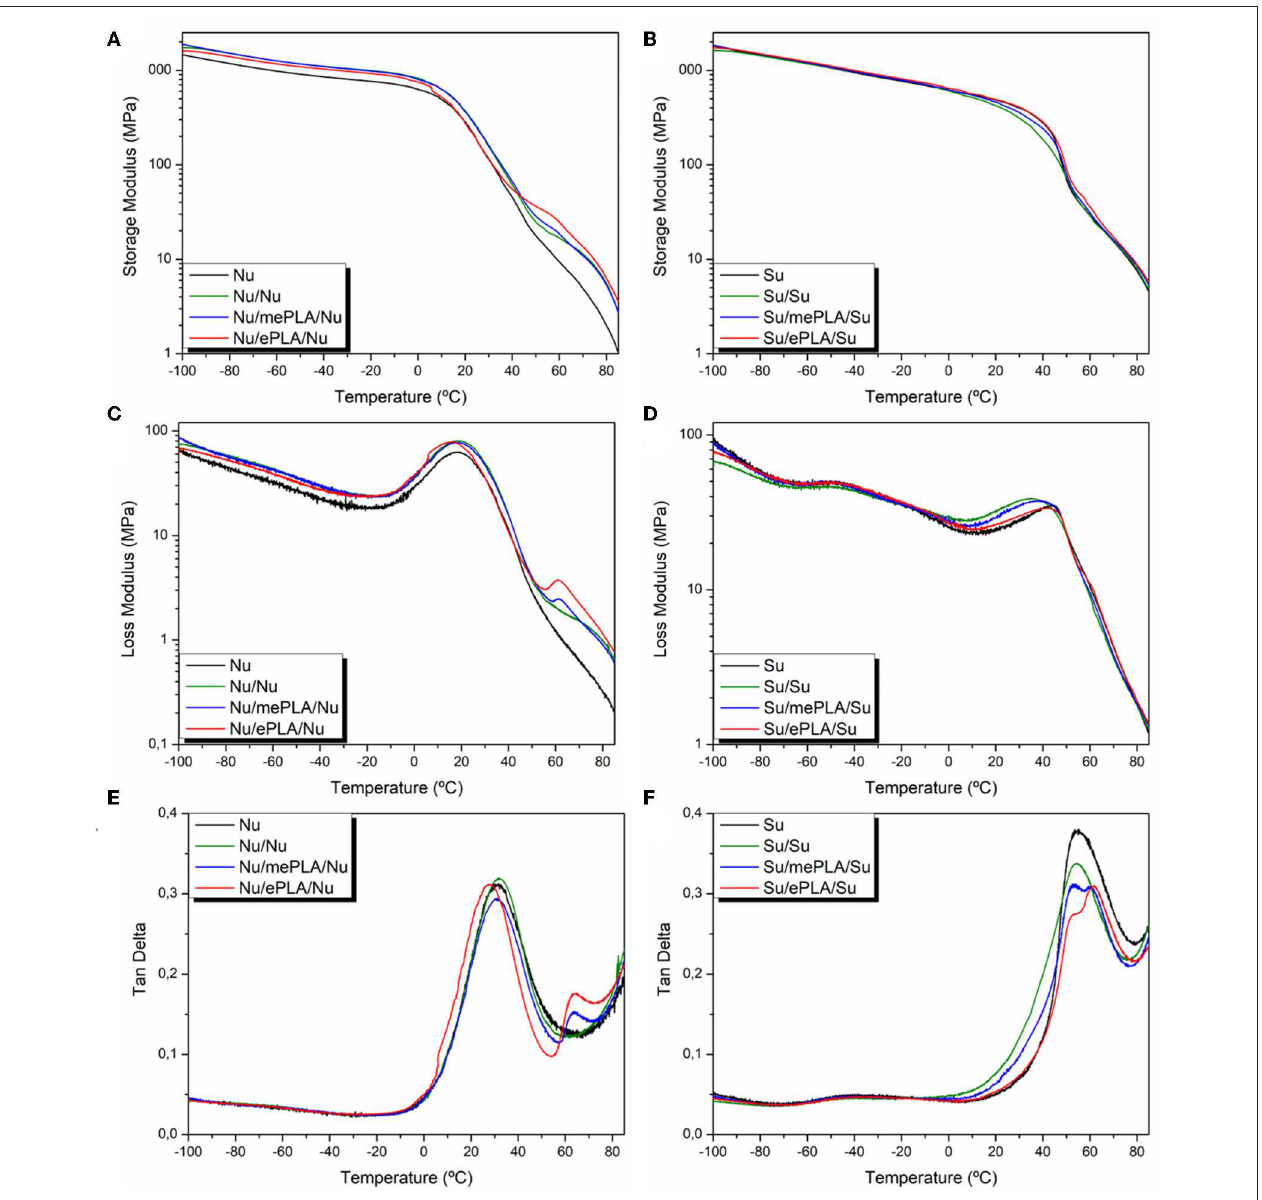
FIGURE 7 | Dynamic mechanical properties: storage modulus (E’), loss modulus (E”) and damping factor (tan δ ) as a function of temperature of (A,C,E) Nucrel-based multilayer reinforced with PLA electrospun microfibers (B,D,F) Surlyn-based multilayer reinforced with PLA electrospun